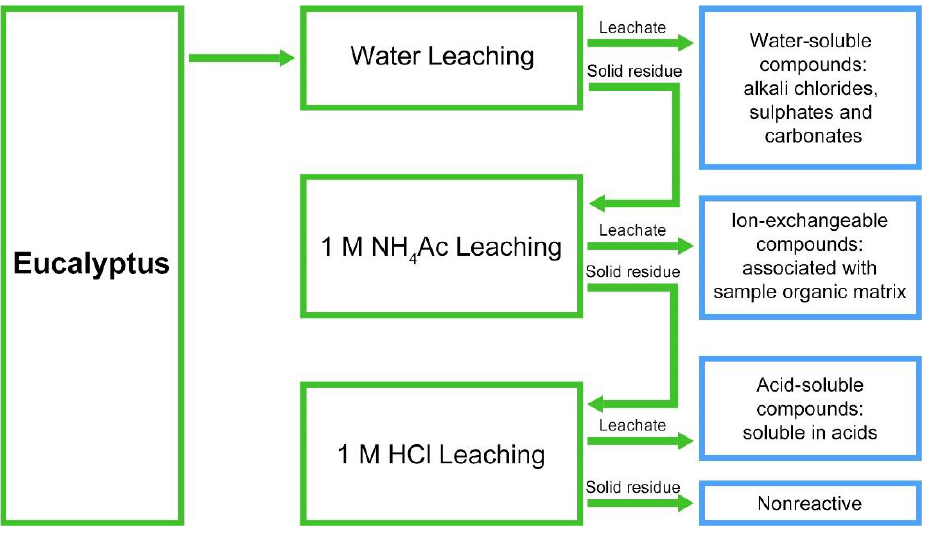
Figure 1. Chemical fractionation general procedure.